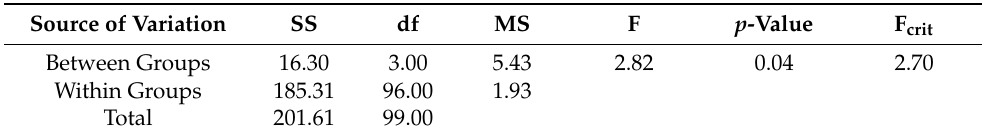
Table 6. ANOVA for CW for the 0.7 mm thick samples welded with and without nitrogen in the shielding gas.